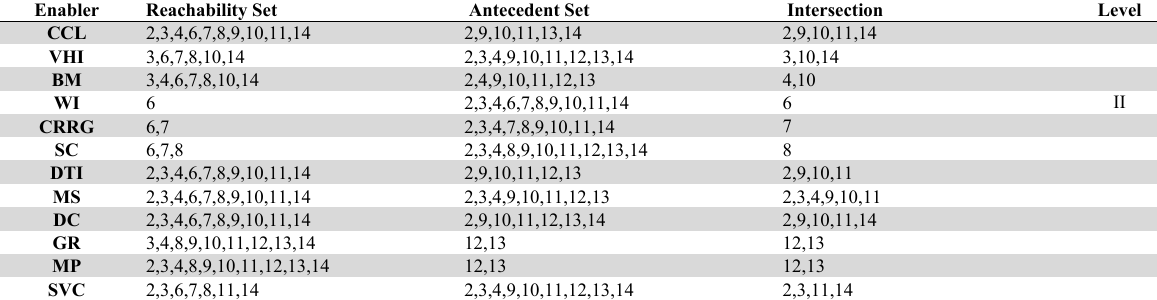
Level partitioning Iteration 2